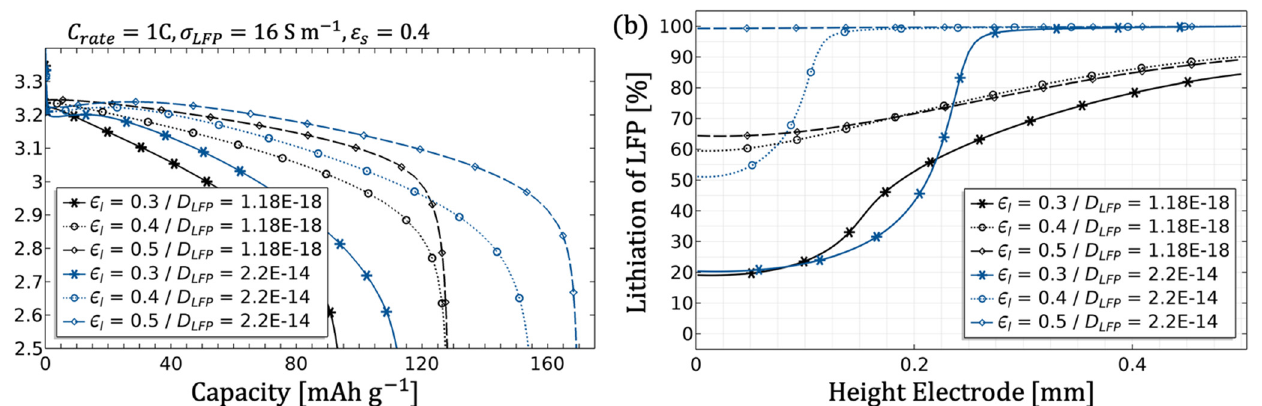
Figure 7. Parameter variation of the filler volume fraction within the LFP electrode. The discharge performance is depicted in ( a ) for the best and the worst solid diffusion at 1C with an optimised ε s = 0.4 and σ LFP = 16 S m − 1 and in ( b ) the lithiation at reaching the cut-off voltage of 2.5 V.